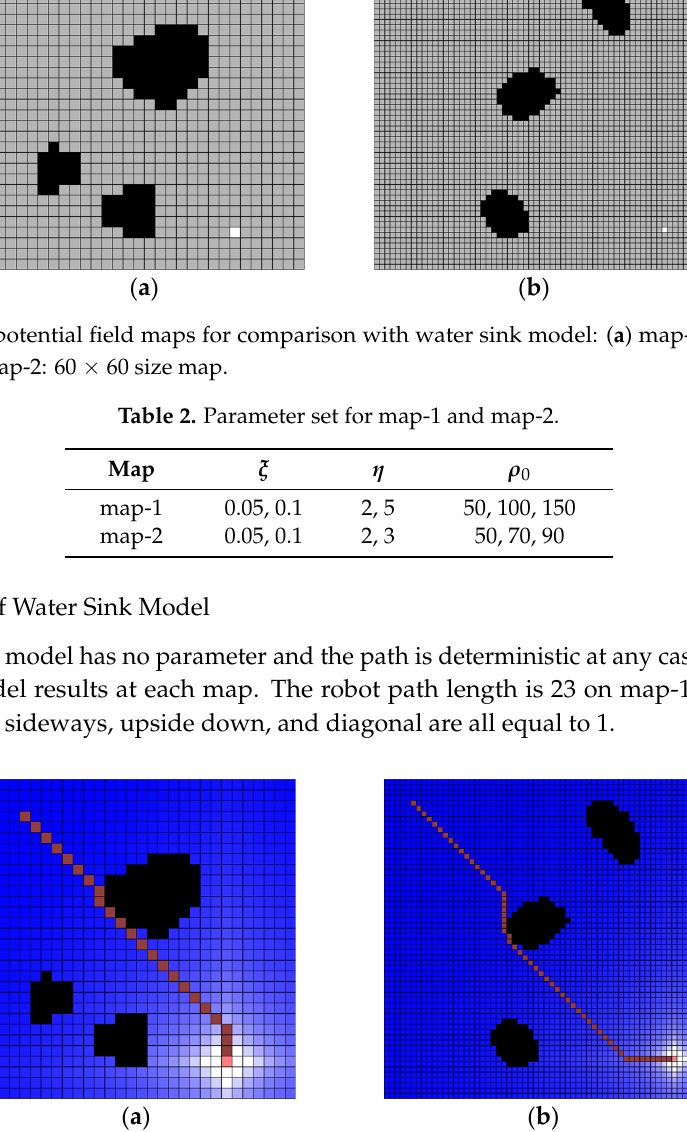
Figure 18. The results of water sink model. The path length is ( a ) map-1: 23, the same as Figure 10c; and, ( b ) map-2: